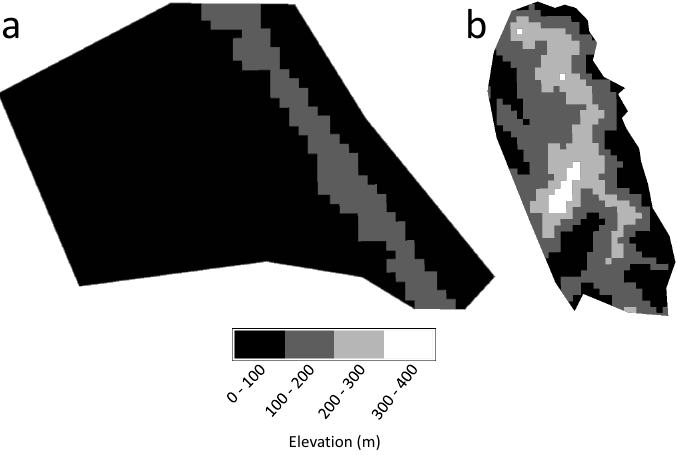
Figure 7. Elevation map of ( a ) Guiuan and ( b )